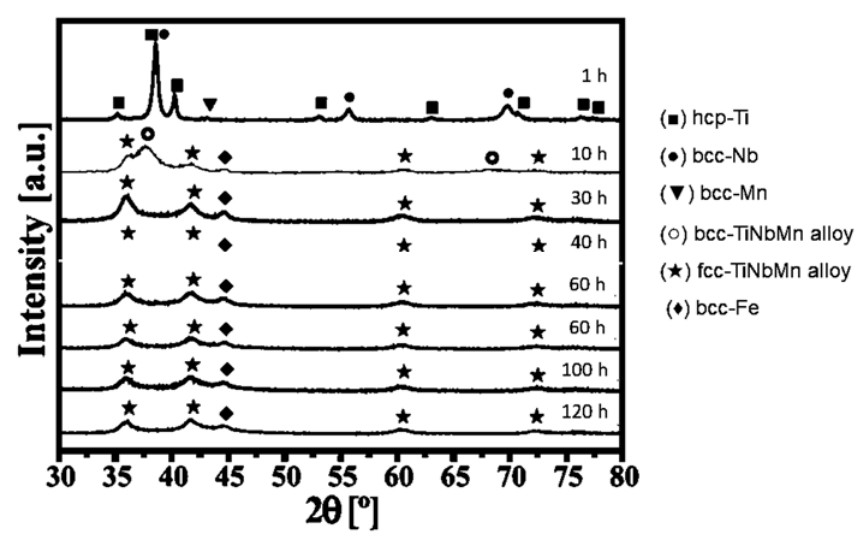
Figure 9. Evolution of XRD pattern as a function of milling time for Ti ‐ 33Nb ‐ 4Mn (at.%) [35]. Table 3. Microstructural parameters as a function of milling time for the Ti ‐ 33Nb ‐ 4Mn alloy [35].